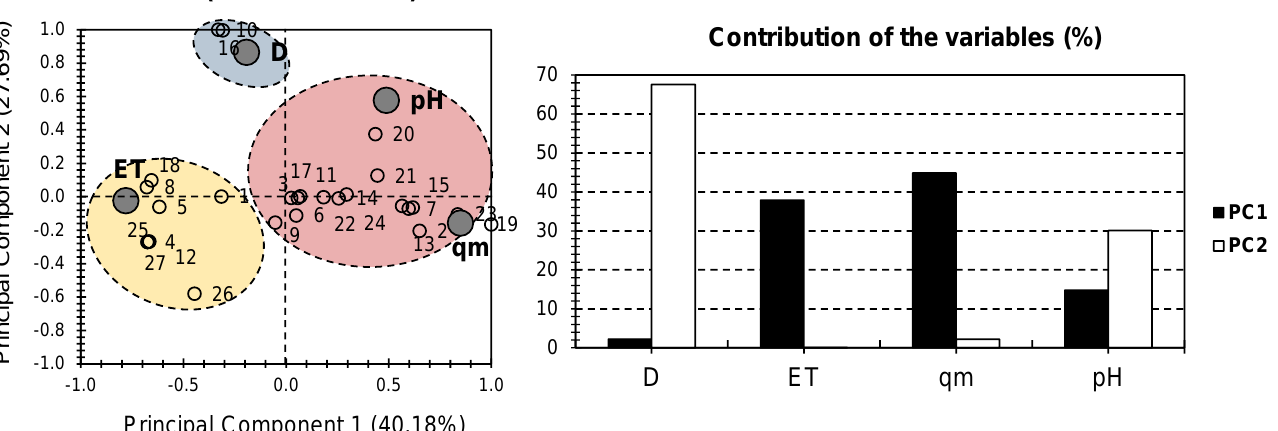
Figure 2. PCA for all datasets. Small empty bullets represent the 27 investigated hydrogels containing MONPs. Large gray bullets represent different physical and chemical properties, with the exclusion of MONP%.